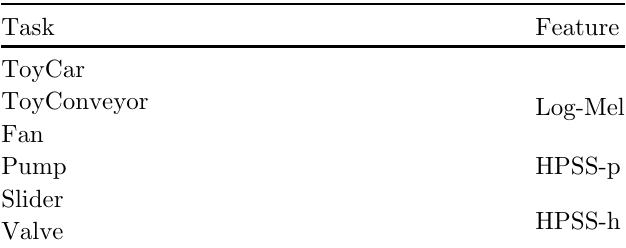
Table 1. Tasks and feature extraction methods pre- allocation table.